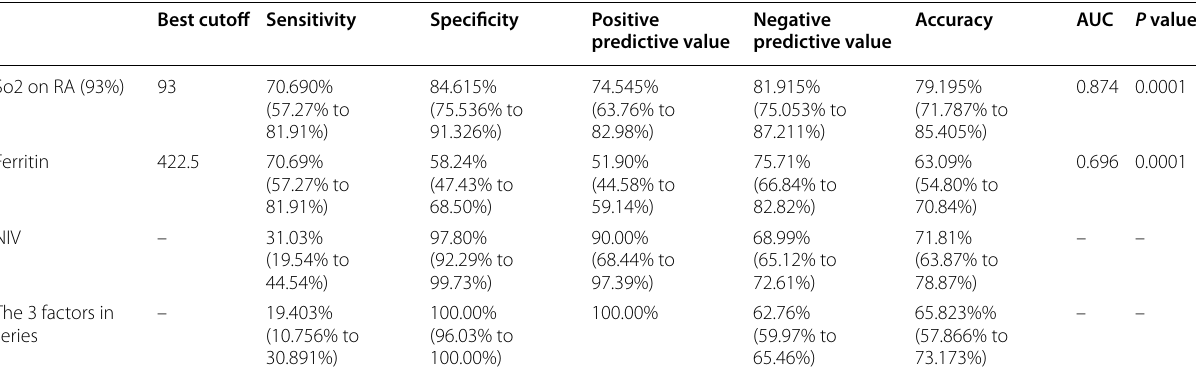
Table 1 Diagnostic test accuracy for prediction of admission to intensive care unit